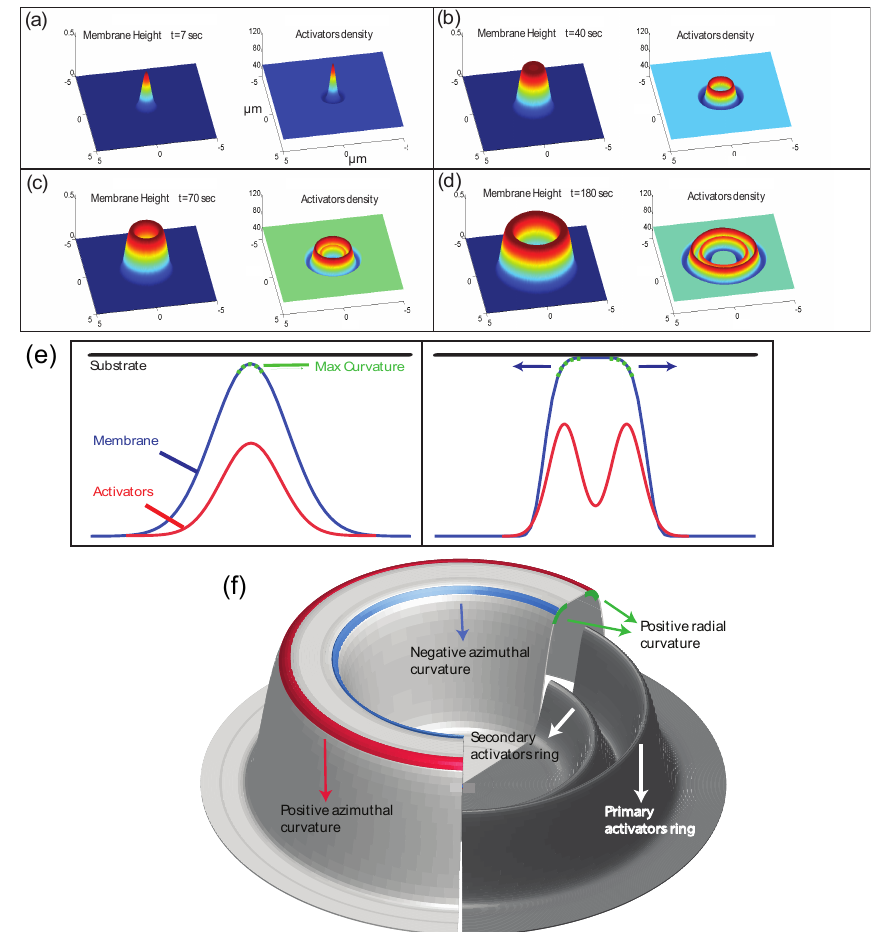
Figure 1. ( a – d ) Numerical integration of Equations (10) and (11) over a period of 3 min, over a membrane segment of size 10 × 10 µ m 2 . The parameter values used: D = 0.1 µ m 2 /s, ¯ H = − 10 µ m − 1 , n 0 = 50 µ m − 2 , n s = 300 µ m − 2 , A = 3.8 · 10 − 5 kg µ m 5 sec − 2 , κ = 20 k B T, σ = 8.28 · 10 − 5 kg µ m 4 sec − 2 , = 0.5 µ m. ( a ) Initial growth of the protrusion, prior to contact µ = 1.66 · 10 6 sec µ m − 2 kg − 1 , h wall